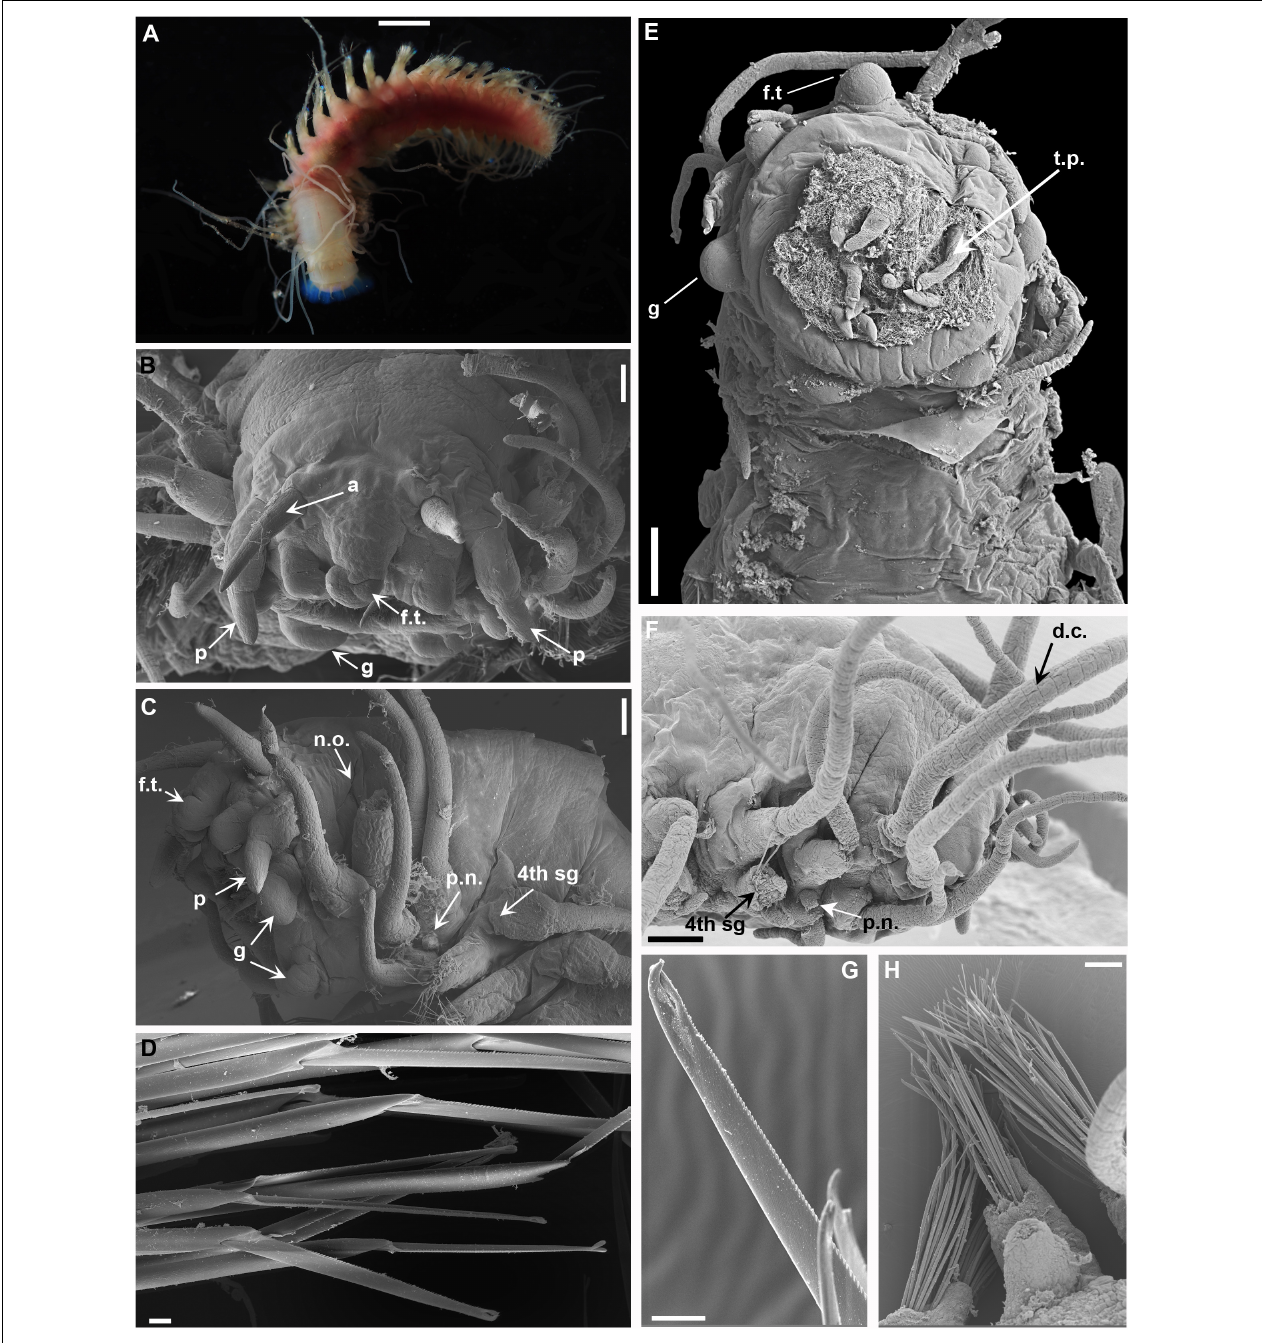
FIGURE 6 | (A) Sirsoe balaenophila comb. nov., specimen from SW Atlantic. (B–D) Sirsoe ypupiara sp. nov.; (B) anterior end, dorsal view; (C) anterior end, lateral view; (D) neurochaetae. (E–H) : S. pirapuan sp. nov.: (E) anterior end, ventral view; (F) anterior end, lateral view; (G) neurochaetae; (H) median neuropodia. 4th sg, fourth segment; a, lateral antenna; d.c., dorsal cirri; f.t, frontal tubercle; g, glandular lip pad; p, palps; p.n., papilliform neuropodial lobe; n.o., nuchal organs. Scales: (A) 3 mm; (B,E,F) 200 µ m; (C,H) 100 µ m; (D,G) 10 µ